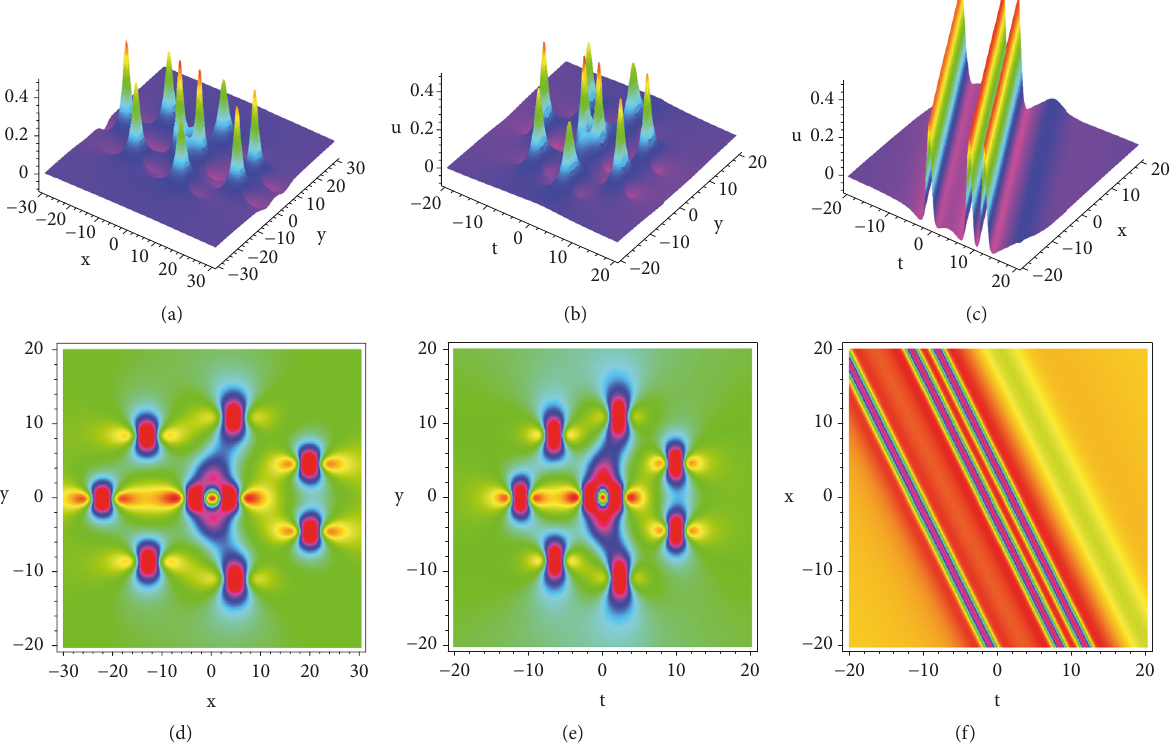
Figure 8: Plots (colored online) of 8-lump wave 𝑢 (21) with 𝑚 = 2, 𝑎 = −2 , 𝛼 = 3×10 9 ,𝛽 = 4×10 9 , 𝑏 0,12 = 𝑐 12,0 = 1,𝑎 18,0 = 600 . (a) Perspective view of the wave 𝑢(𝑥,𝑦, 0) , (b) perspective view of the wave 𝑢(0,𝑦, 𝑡) , (c) perspective view of the wave 𝑢(𝑥, 0,𝑡) , (d) overhead view of the wave (a), (e) overhead view of the wave (b), and (f) overhead view of the wave (c).